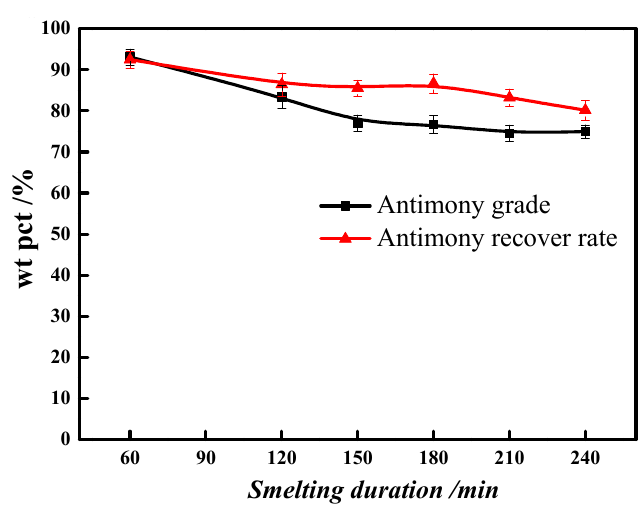
Figure 8. Influence of reaction time on the extraction of antimony and antimony grade. ( α salt = 1.0, W NaCl : W salt = 40%, α Fe = 1.0, W coke : W stibnite = 30%, 850 °C (1123 K)). 2 O 3